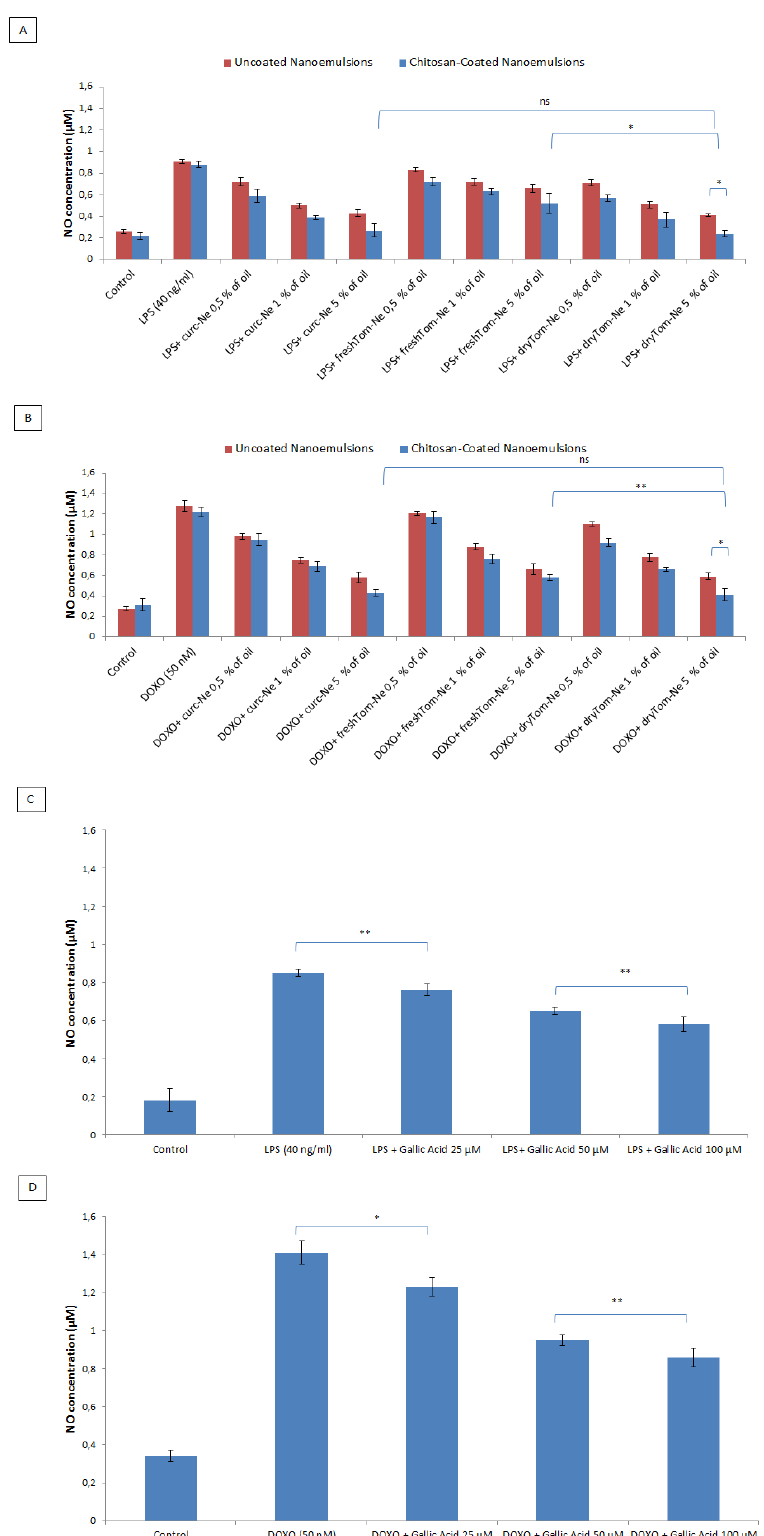
Figure 8. Measurement of nitric oxide (NO) production expressed as nitric oxide concentration ( µ M) in H9c2 cells (5000 cells/well). Cells were pretreated or not with uncoated and chitosan-coated nutraceutical-loaded nanoemulsions at 0.5%, 1% and 5% of oil 4 h before stimulation with 40 ng/mL of LPS ( A ) or 50 nM of DOXO, ( B ) for 24 h. Pretreatments were also performed by incubating cells with gallic acid, as positive control, for both LPS ( C ) and DOXO ( D ) treatments. * p < 0.001; ** p < 0.05; ns: not significant.